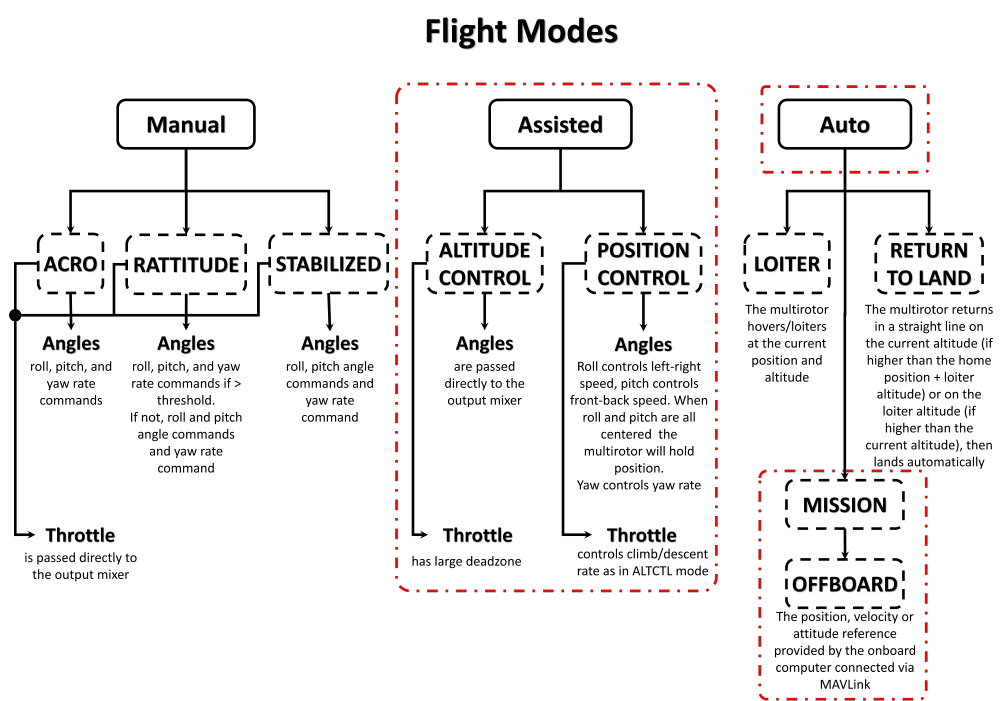
Figure 7. Pixhawk autopilot flight